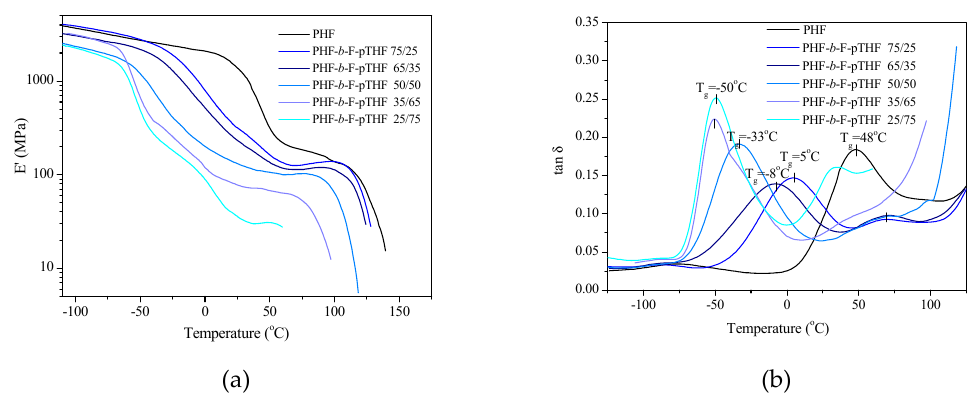
Figure 5. The storage modulus E’ ( a ) and tan δ ( b ) as a function of temperature for PHF- b -F-pTHF